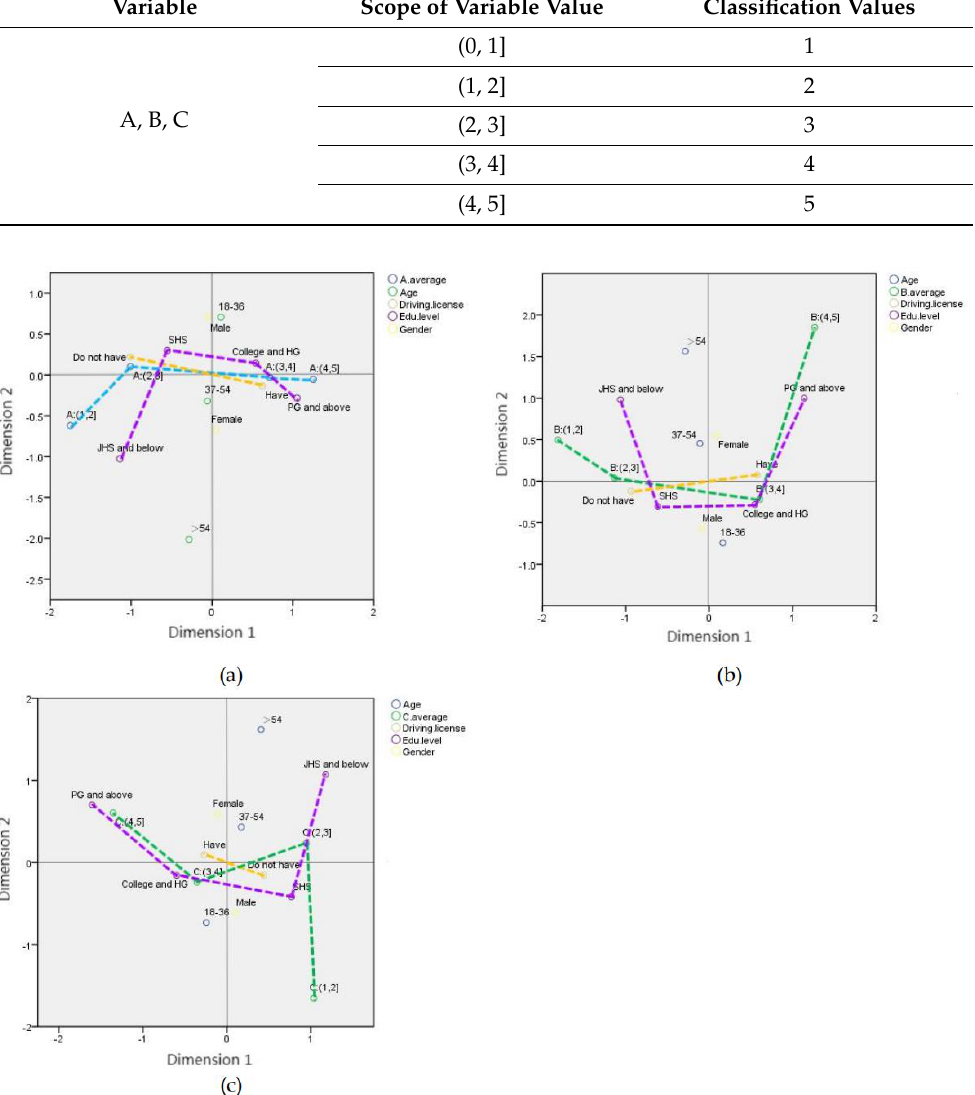
Table 5. The scores of variables (A, B, and C) and the values after classification.